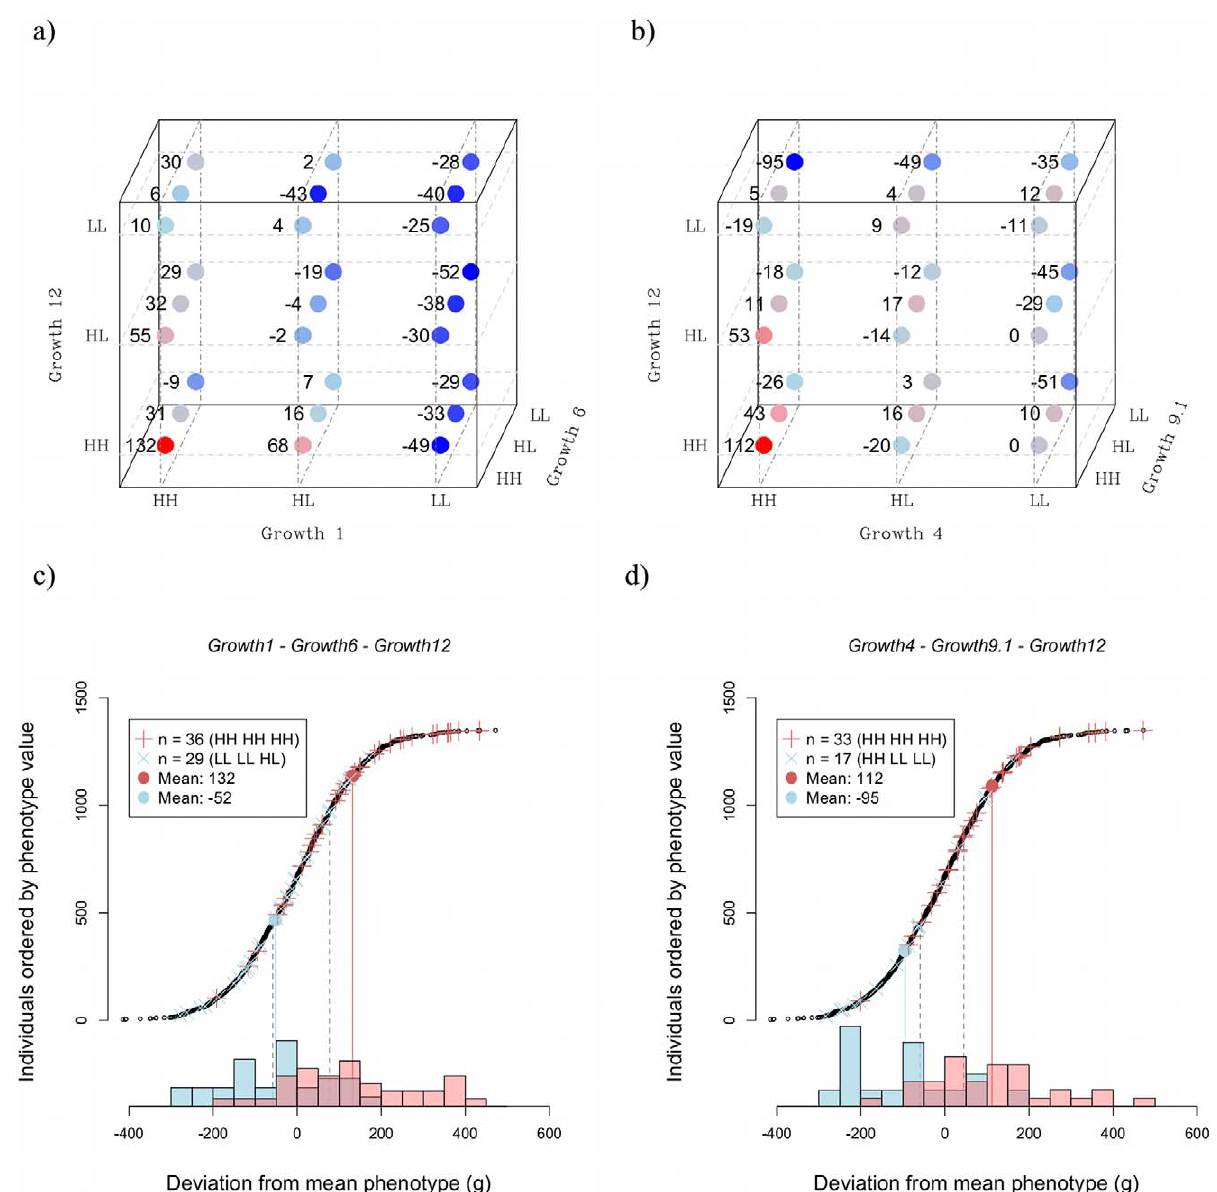
Figure 5. Three-way epistatic interactions. Panel a shows the mean phenotype values for each genotype for the triplet Growth1 - Growth6 - Growth12 ; panel b shows the same for the triplet Growth4 - Growth9.1 - Growth12 . The values shown are the mean (over all individuals with that genotype) of the difference from the average for the class – that is all individuals with the same sex and belonging to the same generation. Thus, positive values in the graph indicate that individuals carrying that genotype are, on average, larger than expected for their class. Panel c shows the distribution of phenotype values for the Growth1 - Growth6 - Growth12 triplet, and panel d shows the same for the Growth4 - Growth9.1 - Growth12 triplet. The red ‘‘ + ’’ symbols show individuals with the high-weight genotype, the blue ‘‘x’’-symbols indicate individuals with the low weight genotype. The correspondingly coloured circles show the genotype mean. Phenotypic values for all individuals are shown as black circles and the inserted histograms show the phenotype distributions for the high-weight (red) and low-weight (blue) genotypes. The expected range based on the additive effects of the loci is shown as dashed grey lines.